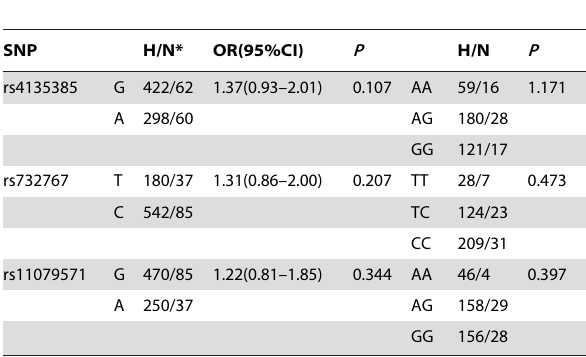
Table 6. Comparison of SNPs in high ESR group versus normal ESR